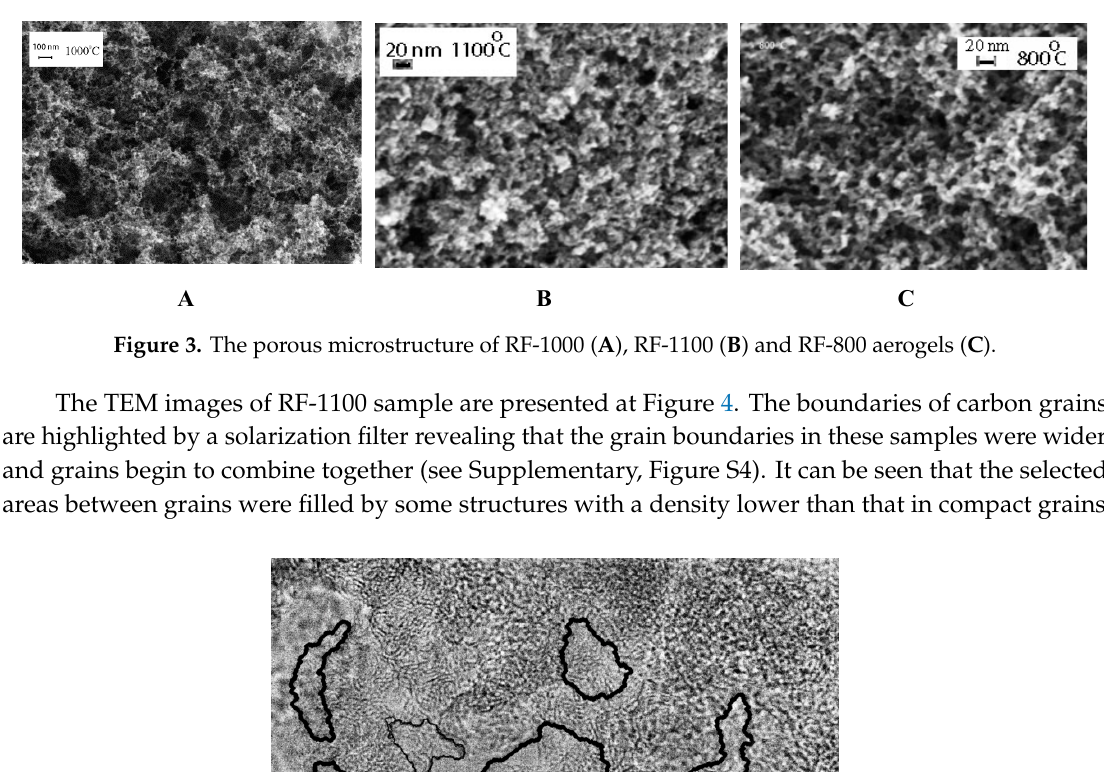
Figure 4. The TEM image of the RF-1100 sample. Graphene scales between carbon grains are visible in blue.